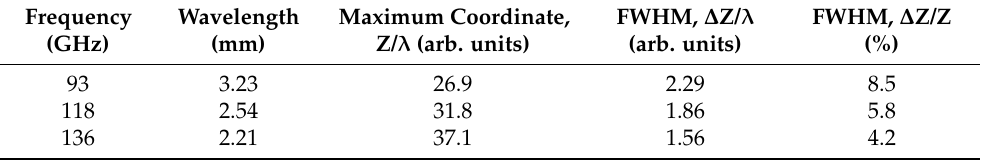
Table 1. The parameters of MM radiation intensity Z-distribution for different switching